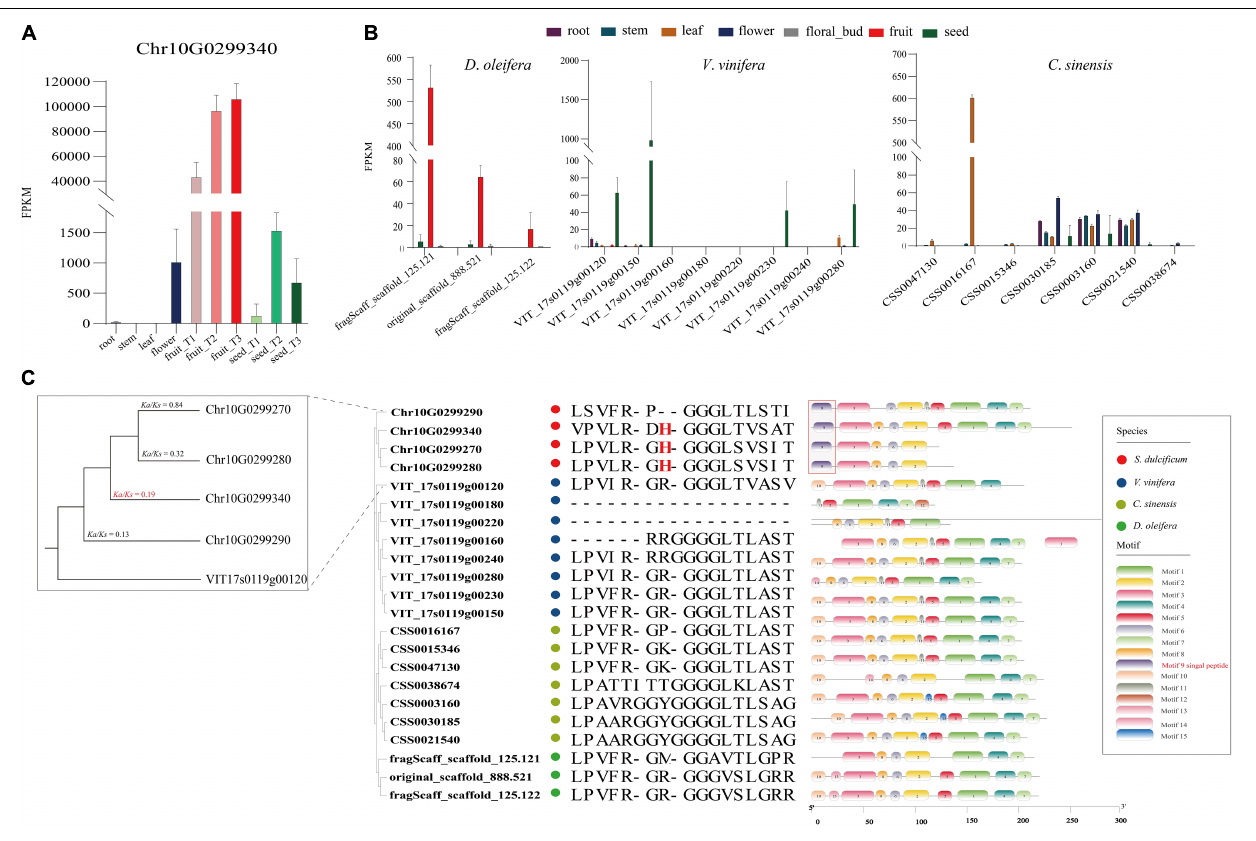
FIGURE 7 | Expression level, phylogenetic tree, and unique protein sites of miraculin and its homologous genes in S. dulcificum and genetically close species. (A) Expression levels of miraculin in various tissues of S. dulcificum . FPKM values were used. (B) The expression level of homologous genes of miraculin in tissues of D. oleifera , V. vinifera , and C. sinensis . (C) The phylogenetic tree, selective pressure analysis, and protein sequence alignment of miraculin and its homologous genes in S. dulcificum , V. vinifera , C. sinensis , and D. oleifera